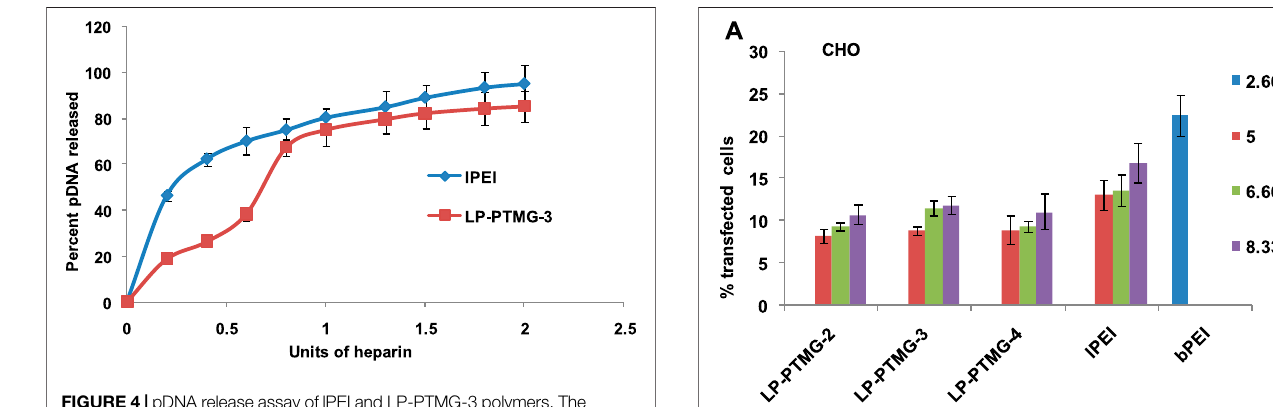
FIGURE 4 | pDNA release assay of lPEI and LP-PTMG-3 polymers. The experiment was performed thrice and error bars represent the standard